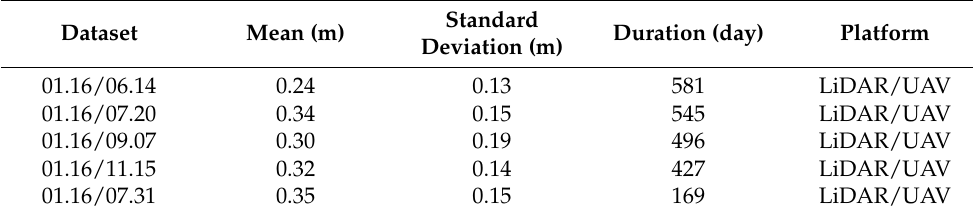
Table 3. The mean and standard deviation of the M3C2 distance in the stable